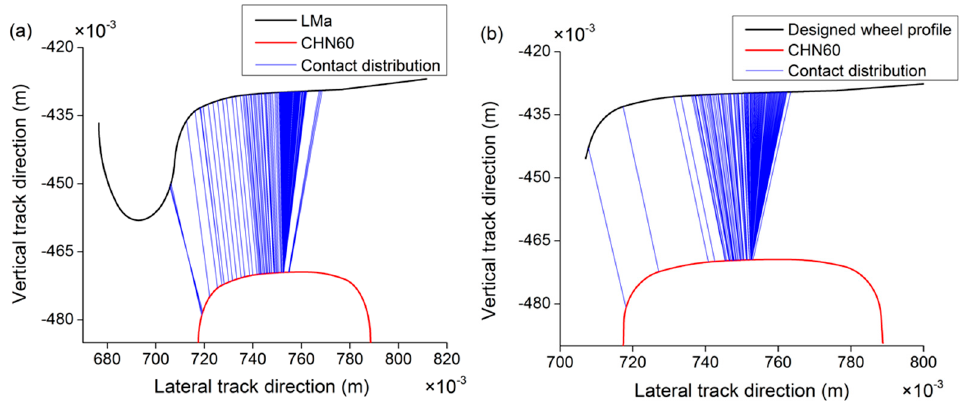
Figure 17. Wheel-rail contact distribution. ( a ) LMa and CHN60; ( b ) Optimized wheel and CHN60.